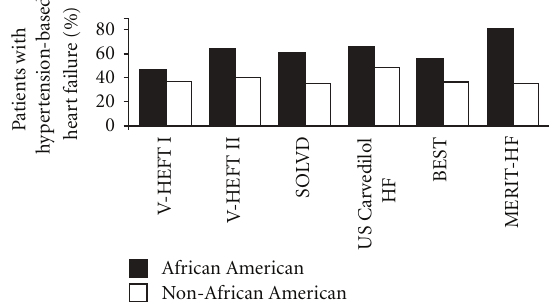
Figure 1: Higher rates of hypertension-based heart failure among African American patients compared to white patients in heart fail- ure trials. V-HEFT: Vasodilator Heart Failure Trial; SOLVD: Studies of Left Ventricular Dysfunction; US Carvedilol: US Carvedilol Heart Failure Trial; BEST: β -Blocker Evaluation of Survival Trial; MERIT- heart failure: Metoprolol CR/XL Randomized Intervention Trial in Congestive Heart Failure [14].